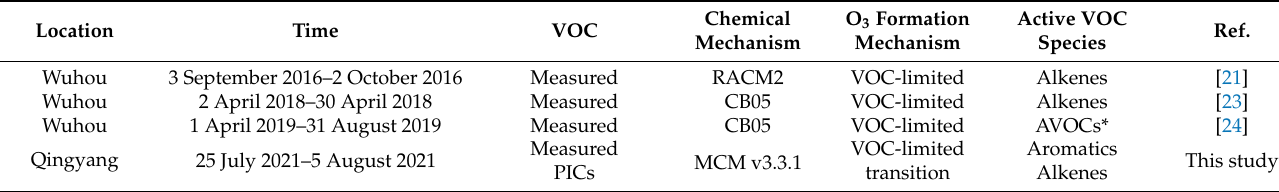
Table 2. Summary of the OBM studies in O 3 formation regime at urban areas of Chengdu.